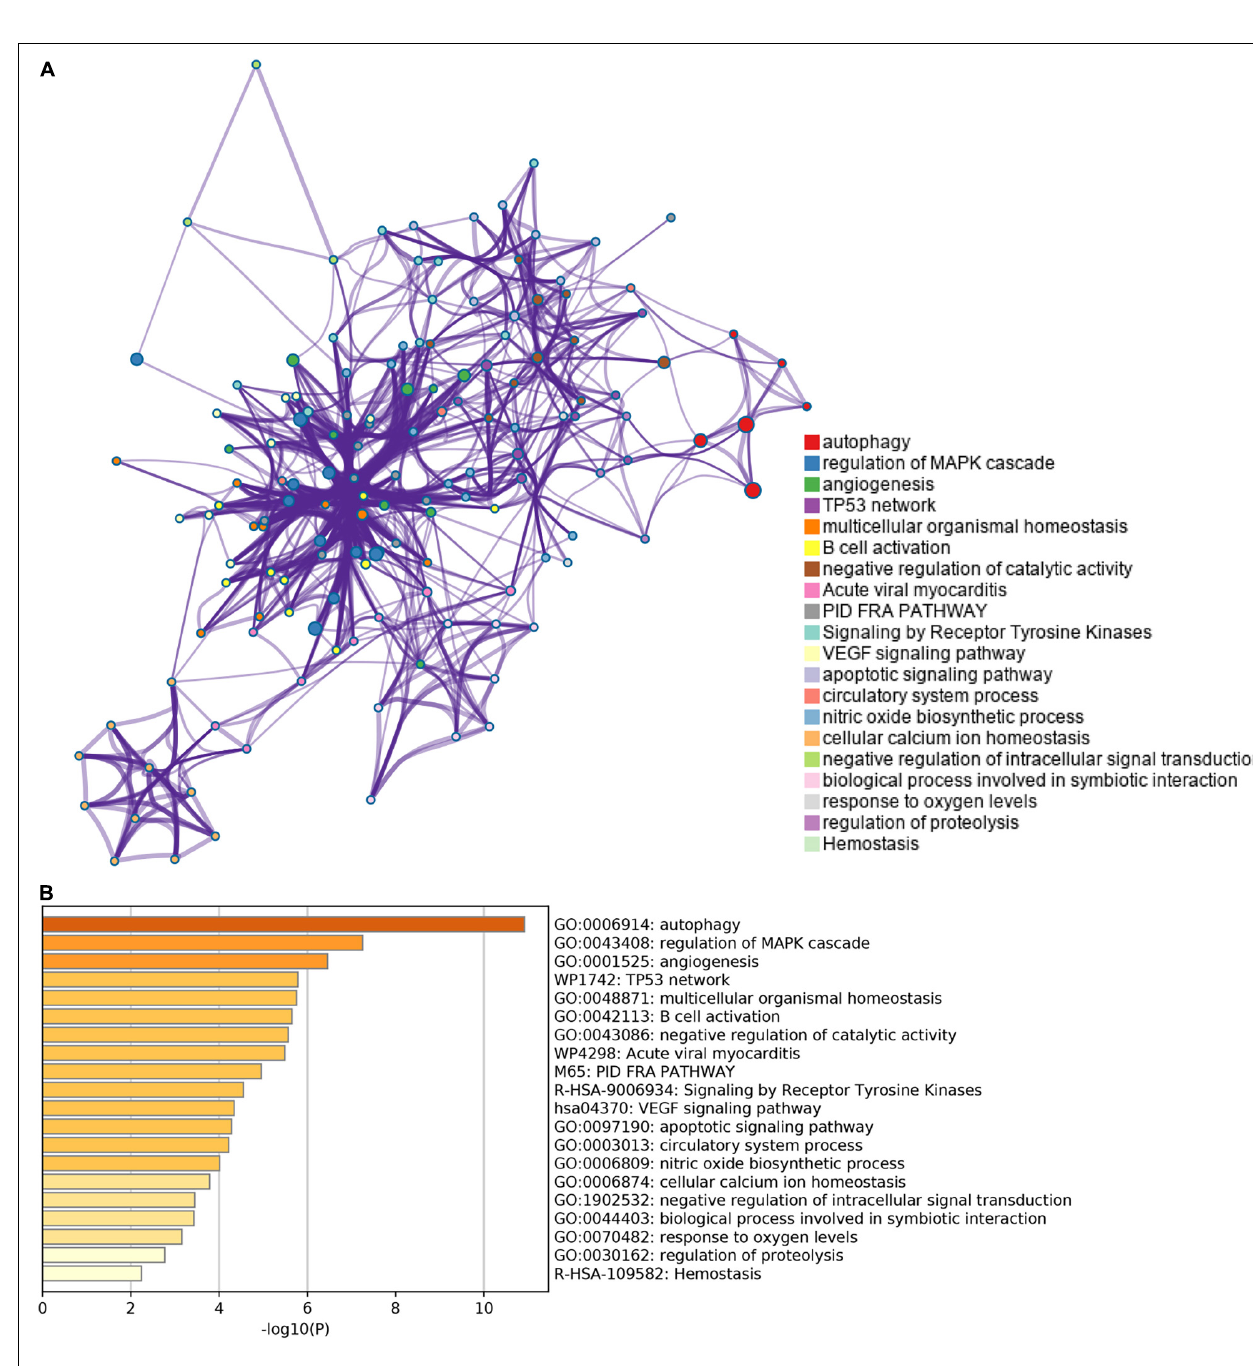
Frontiers in Cardiovascular Medicine |